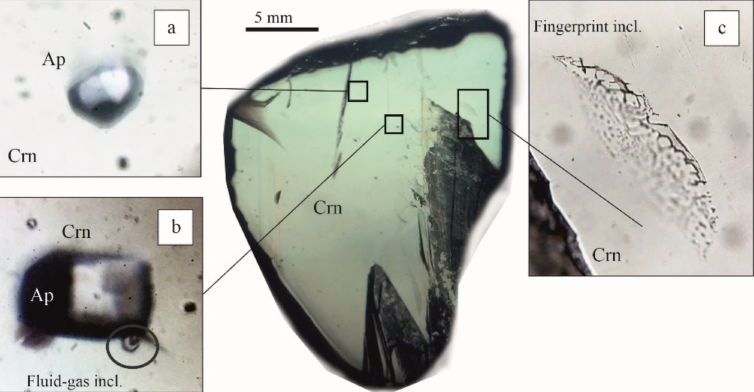
Figure 7. Mineral and fluid inclusions in the Naryn-Gol Creek sapphires. ( a )—monophase apatite inclusion; ( b )—multiphase inclusion; ( c )—fingerprint inclusions. Ap: apatite; Crn: corundum; incl.: inclusion.